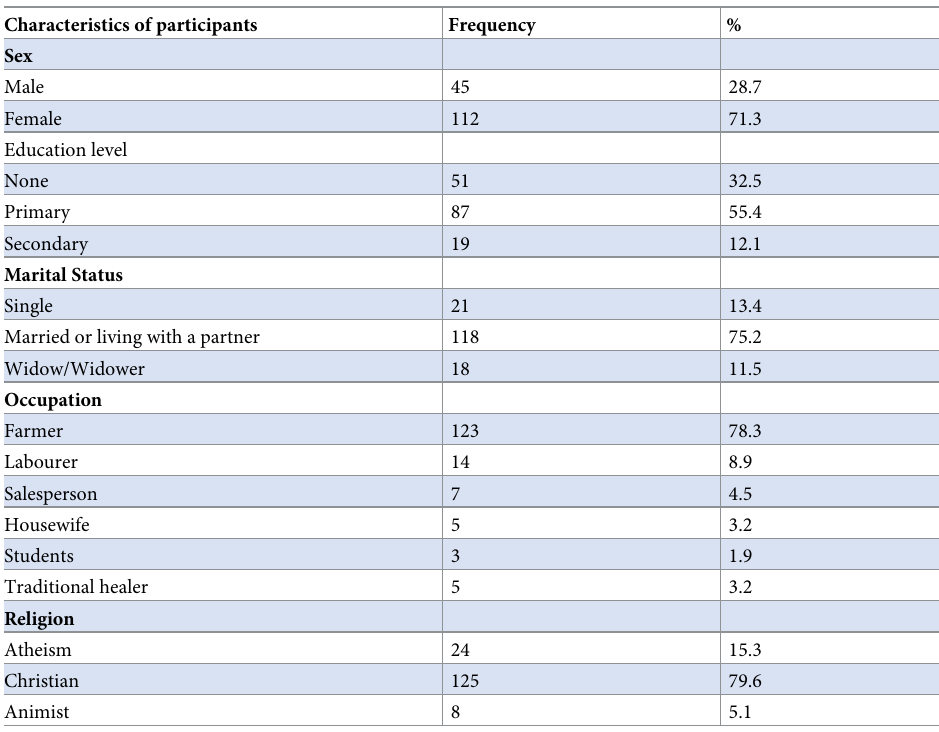
Table 3. Sociodemographic characteristics of focus group discussion participants.